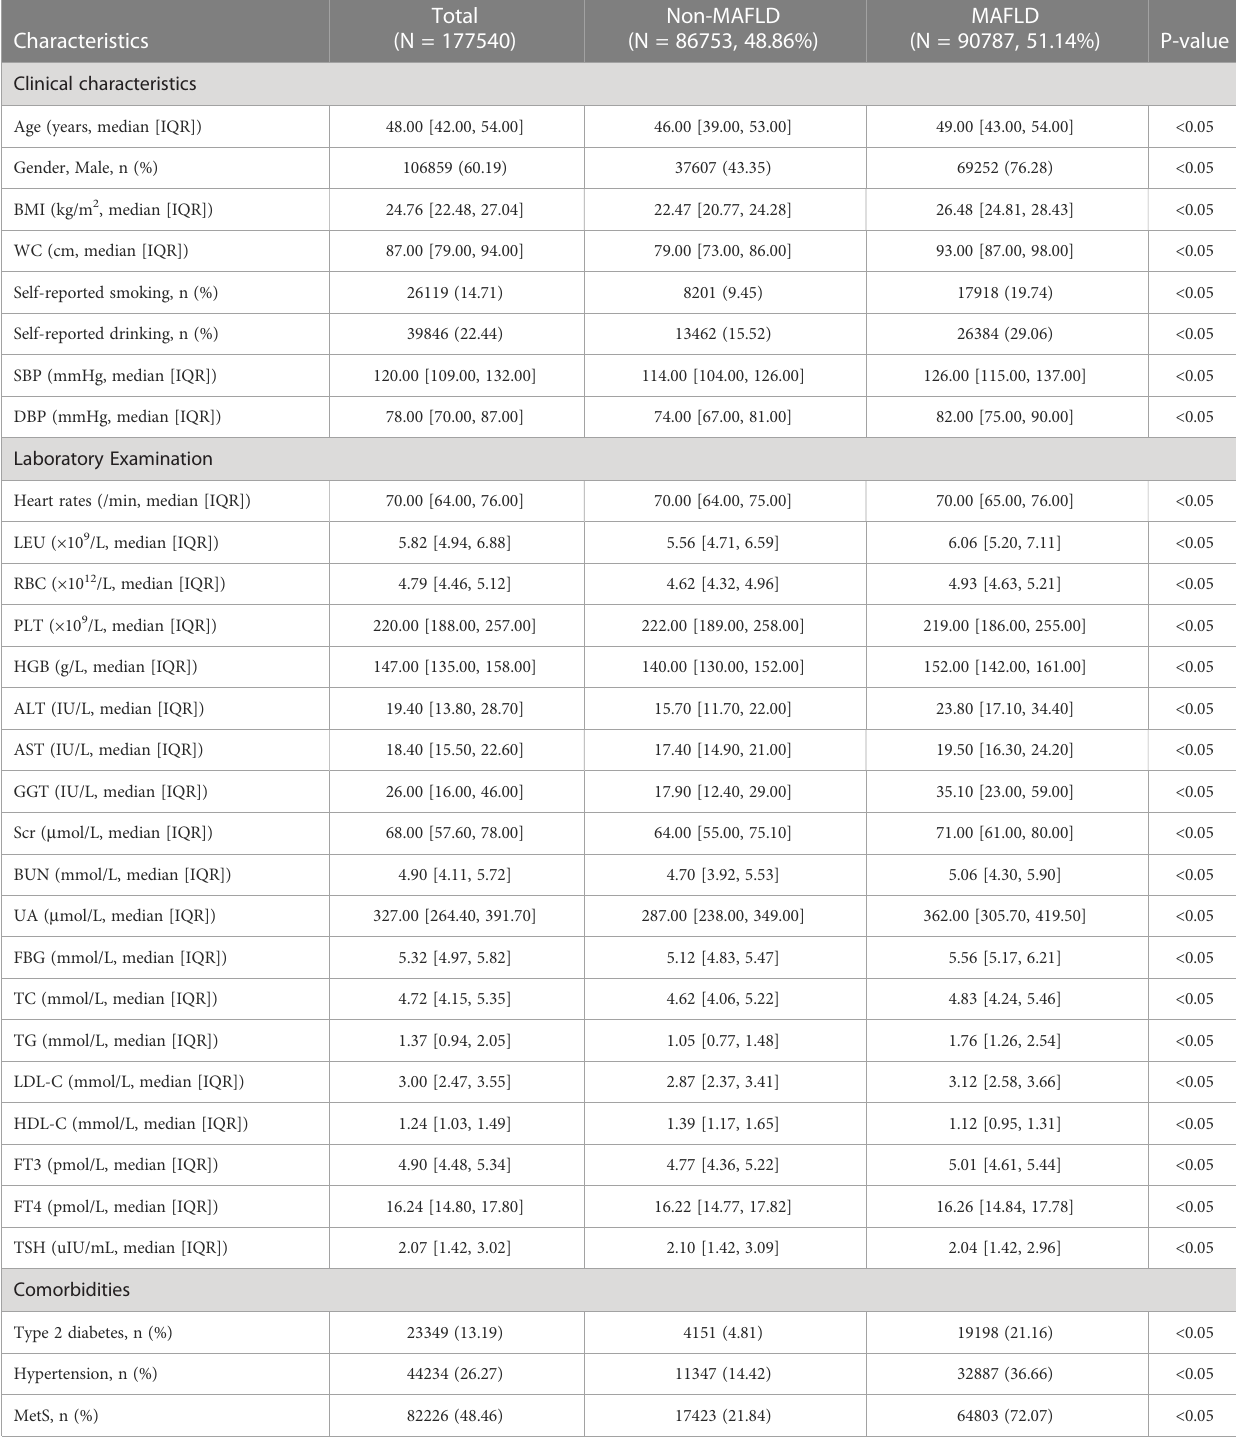
TABLE 1 Clinical and laboratory characteristics of participants with and without MAFLD from 2010 to 2018.